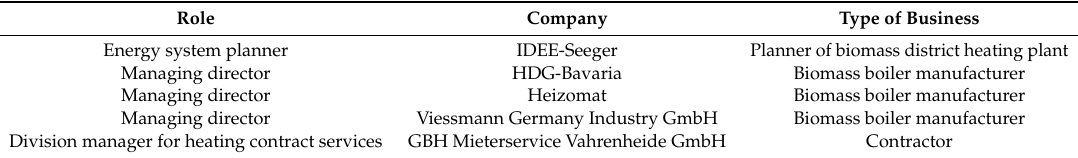
Table A1. Overview of key stakeholders interviewed to identify promising market segments (see also [28]).